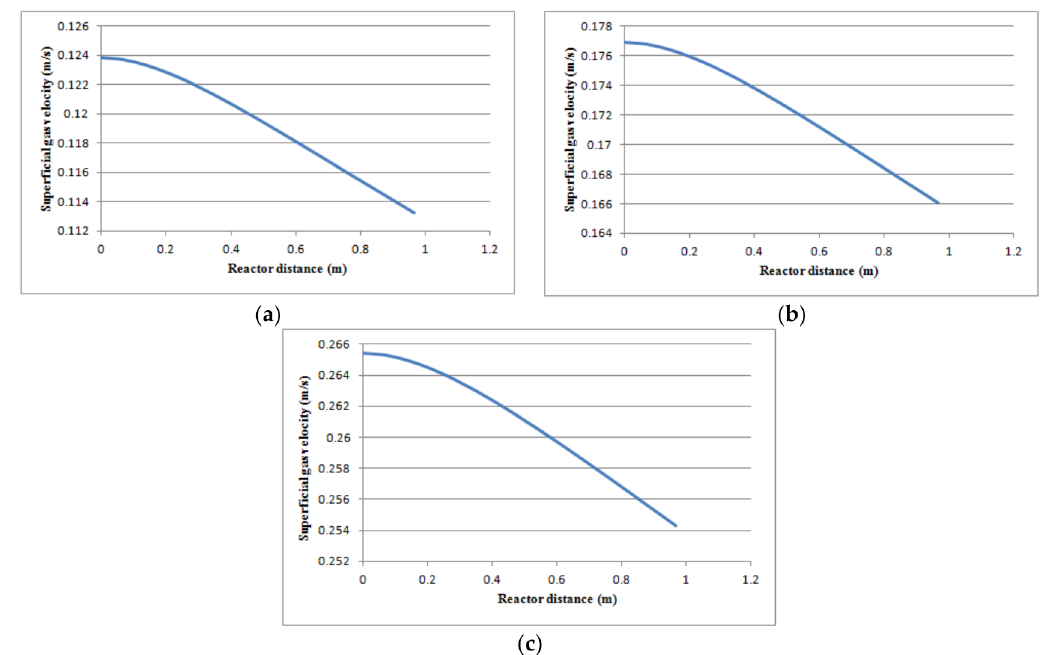
Figure 14. Reduction of superficial gas velocity as a function of reactor height at three different operating load conditions: ( a ) T = 503 K, P = 20 bar, V f = 3.5 m 3 /h; ( b ) T = 503 K, P = 20 bar, V f = 5 m 3 /h; ( c ) T = 503 K, P = 20 bar, V f = 7.5 m 3